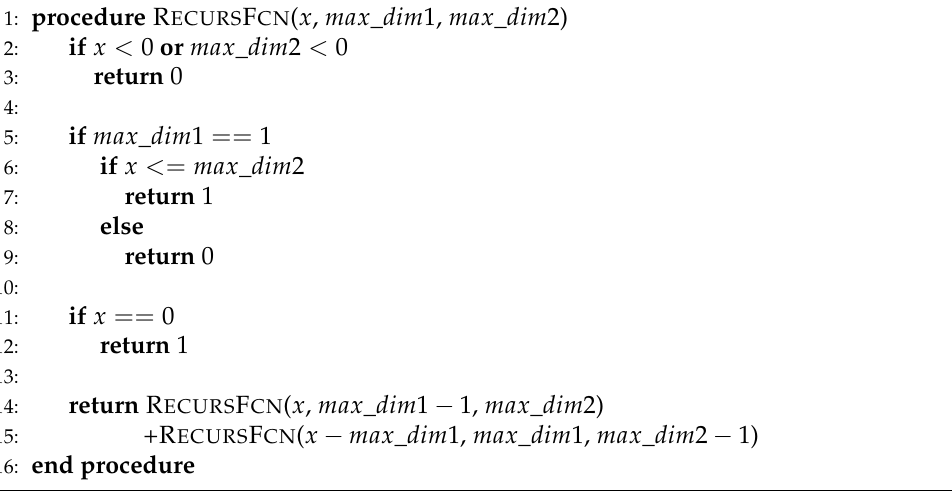
Algorithm 1 Recursive algorithm returning the number of ROC curves that yield an input